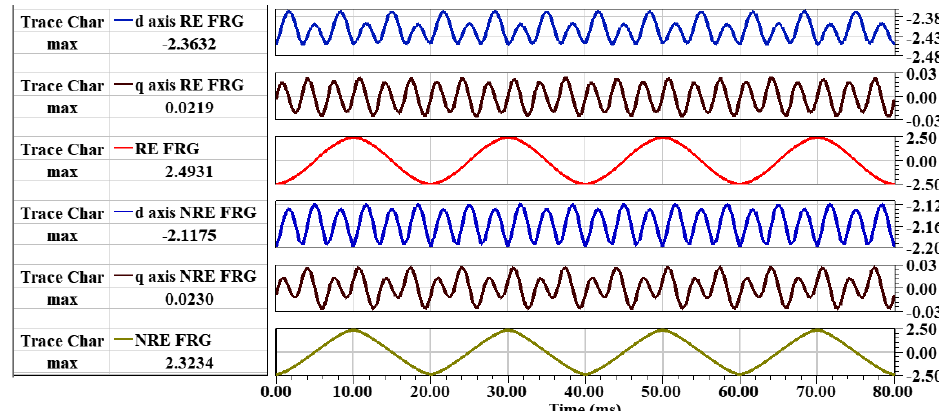
Figure 3. No-load dq- and phase flux linkage waveforms.